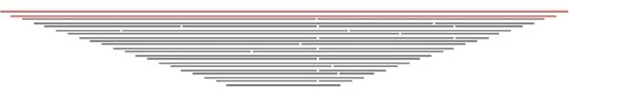
Fig 4. Circle approximation. The concentric circles unrolled and flattened; the sum of their lengths is L = 1.0 π + 1.2 π + ��� + 5.0 π . The red solid turns (of lengths 5.0 π and 4.8 π ) are preserved; the black broken ones (of length L 0 = 1.0 π + 1.2 π + ��� + 4.6 π ) are to be